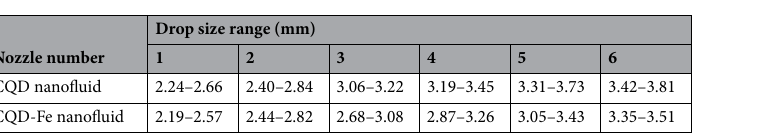
Table 2. The range of generated drop size using different